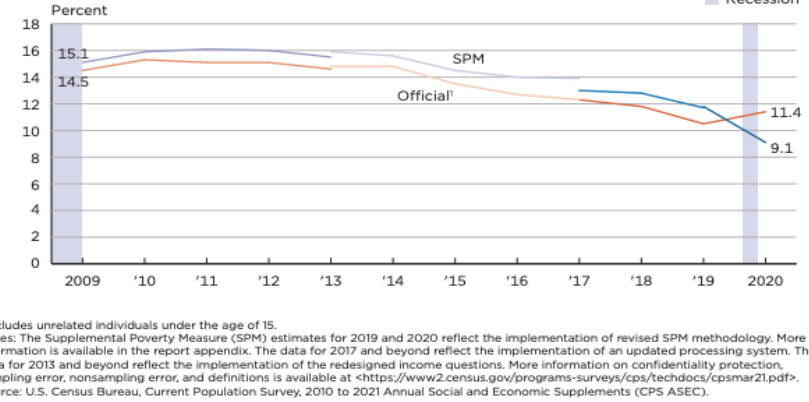
Figure 7. Comparison of the Official and Supplemental Poverty Measures from the US Census Bureau, 2009–2020 [27]. Increased government assistance measures and stimulus payments led to a decrease in the Supplemental Poverty Measure between 2019 and 2020. This figure was created by the US Census Bureau and is in the public domain.